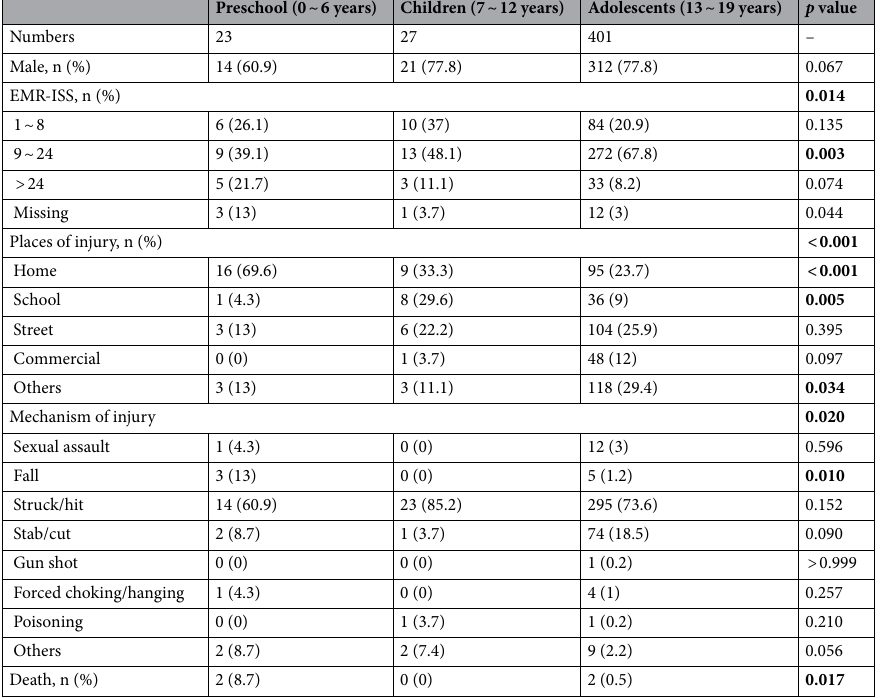
Table 1. Baseline characteristics of different age groups. Alcohol and psychoactive drug/substance use were list in Supplementary Table S1. EMR-ISS excess mortality ratio-adjusted injury severity score. Significant values are in